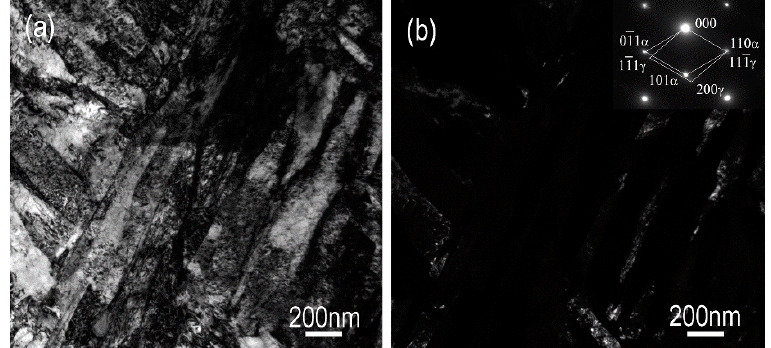
Figure 5. ( a ) BF and ( b ) DF micrographs of the retained austenite at 200 °C, with the corresponding SAED pattern inserted in ( b ).